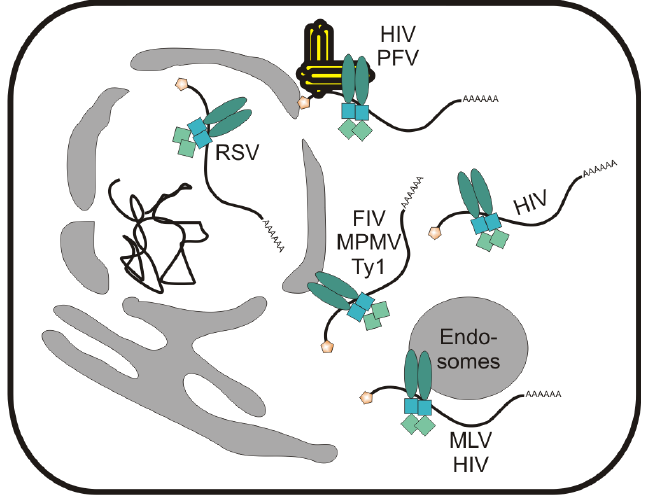
Figure 3. Subcellular sites of Gag-genomic RNA interaction where genomic RNA packaging may be initiated prior to plasma membrane localization. Retroviral Gag-RNA complexes have been visualized in pericentrosomal locations (HIV-1 and PFV) [168, 188, 189], on the cytoplasmic face of endosomes (HIV-1 and MLV) [190,191], on the cytoplasmic face of the nuclear envelope (FIV, MPMV, and Ty1) [19,33,72,192], and within the cytoplasm [193-196]. Genetic and biochemical data suggest that RSV Gag may bind its genomic RNA in the nucleus during transient nuclear trafficking of the Gag protein